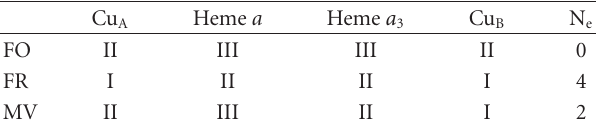
Table 1: Oxidation States of Electron Sites and Number of Electrons ( N e ) Relevant to O 2 Reduction in FO, FR, and MV CcO.